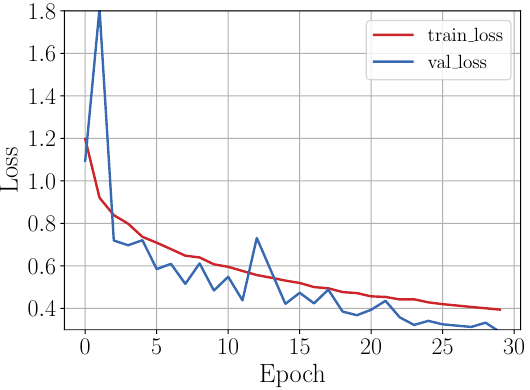
Figure 10. Loss behavior during training stage. To train the model the augmented dataset was used.